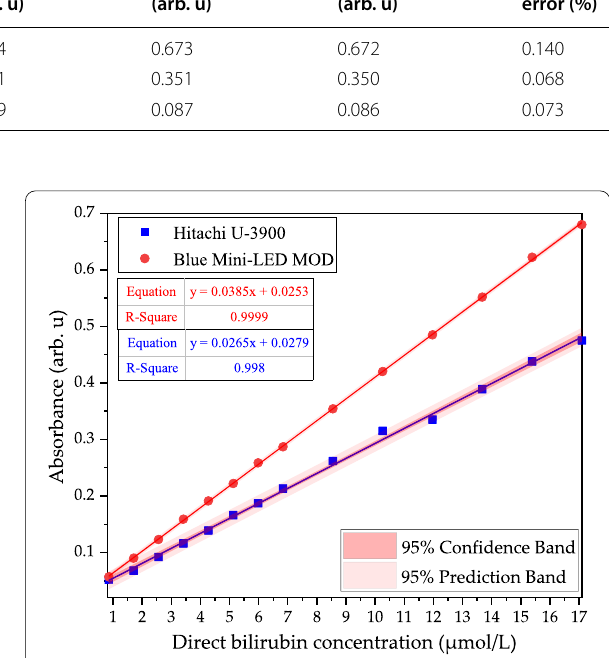
Fig. 11 The R 2 value of direct bilirubin absorbance at 462 nm and 460 nm by the blue Mini‑LEDs MOD and the Hitachi U‑3900